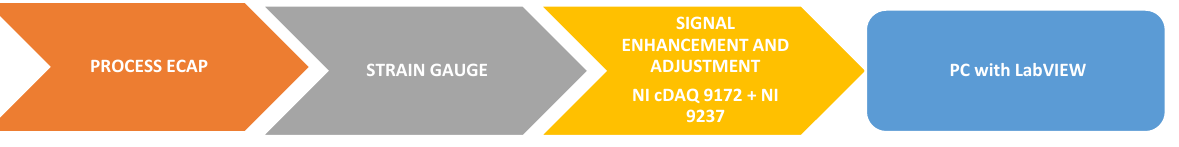
Figure 3. Block diagram of force measurement in the case of the ECAP technology.